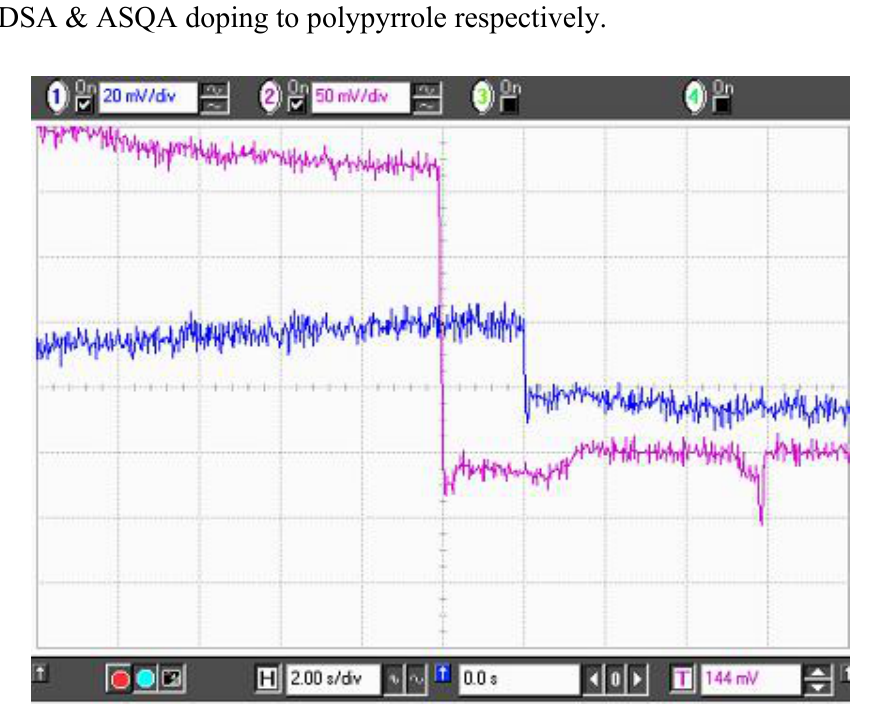
Figure 15. Sensor response for polypyrrole coated fiber upon DMMP